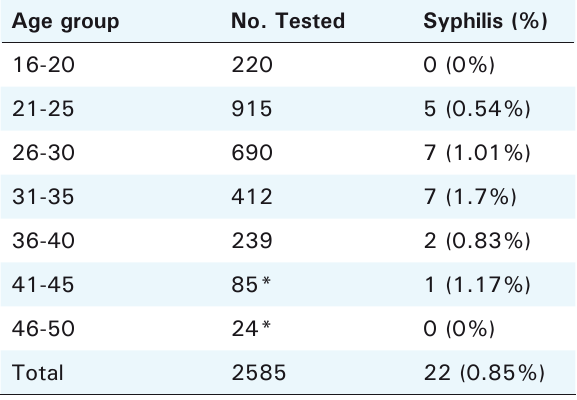
table1. Occurrence of syphilis in different age groups